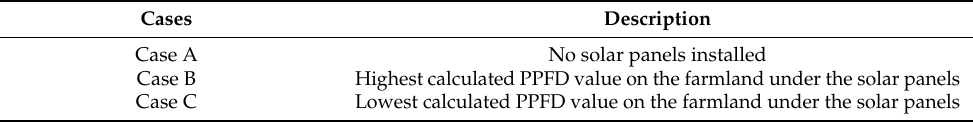
Table 3. Three cases for qualifying impact of solar panels installation on crop shipping time.